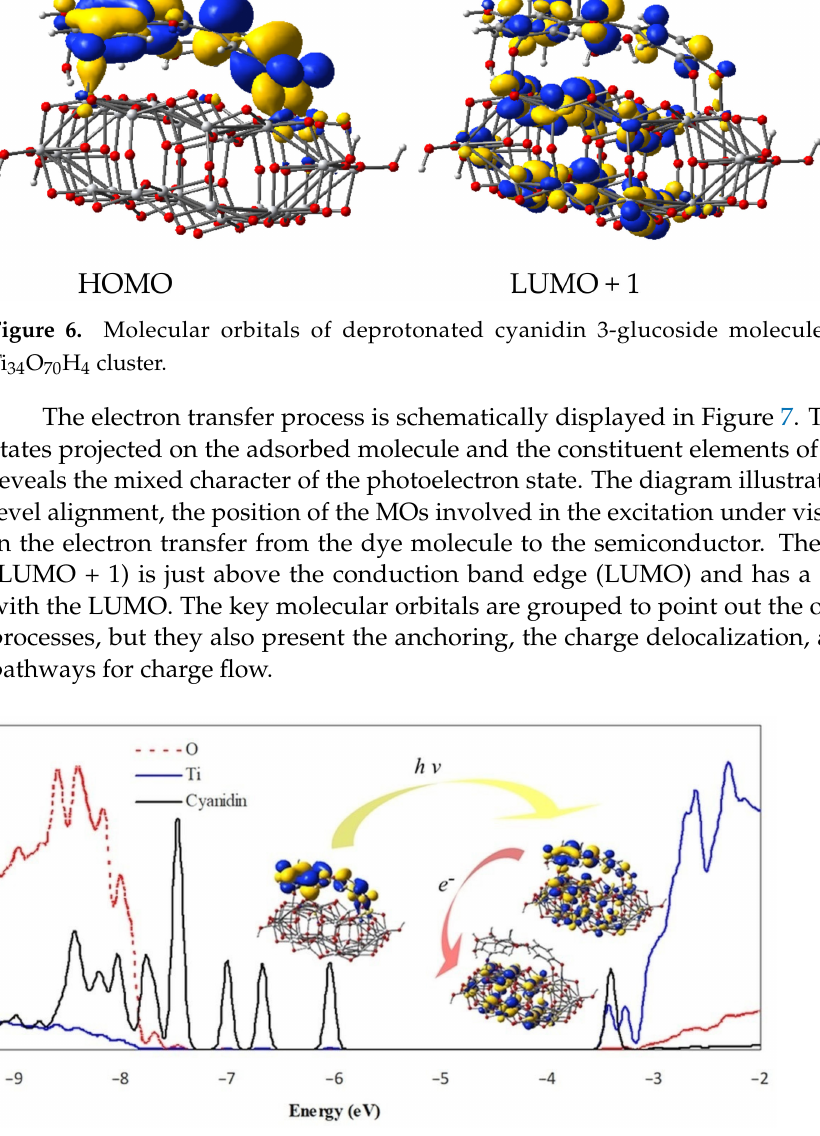
Figure 7. Projected density of states of cyanidin 3-glucoside molecule adsorbed on Ti 34 O 70 H 4 cluster, together with key electronic states. The scale of the cyanidin contribution is double of the scale shown to the left. Energy levels were convoluted with Gaussian distributions of 0.1 eV full width at half